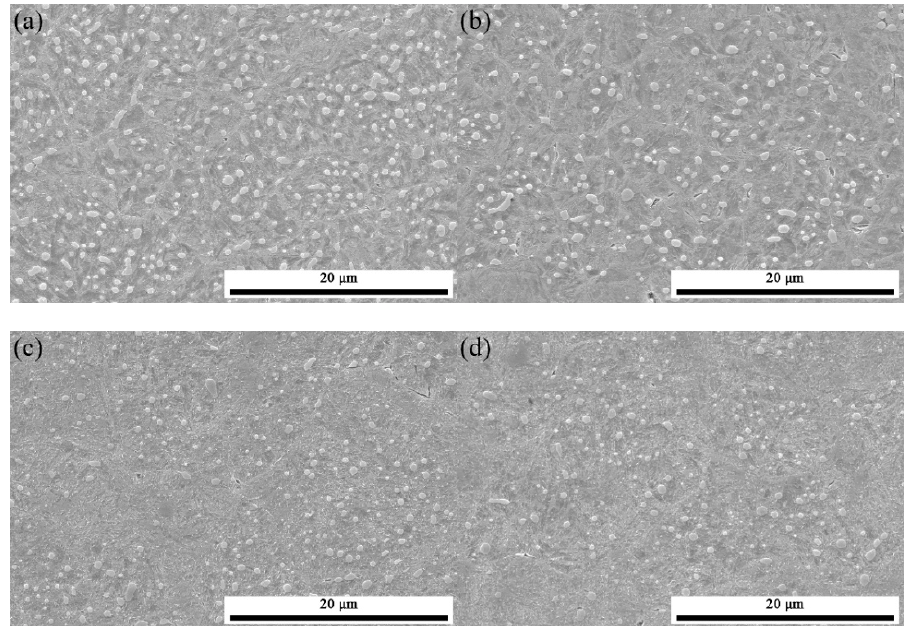
Figure 2. Morphology of spherical carbides after quenching and tempering (QT) with and without cold ring rolling (CRR) under different austenitizing times: Blank/10 specimen ( a ), CRR/10 specimen ( b ), Blank/20 specimen ( c ), and CRR/20 specimen ( d ).